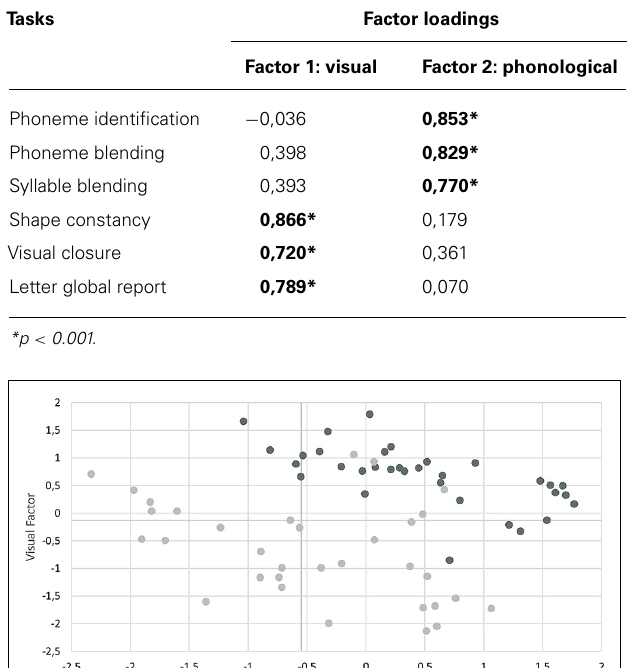
Table 4 | Rotated factor loadings of the PCA for the visual and phonological subtests. Tasks